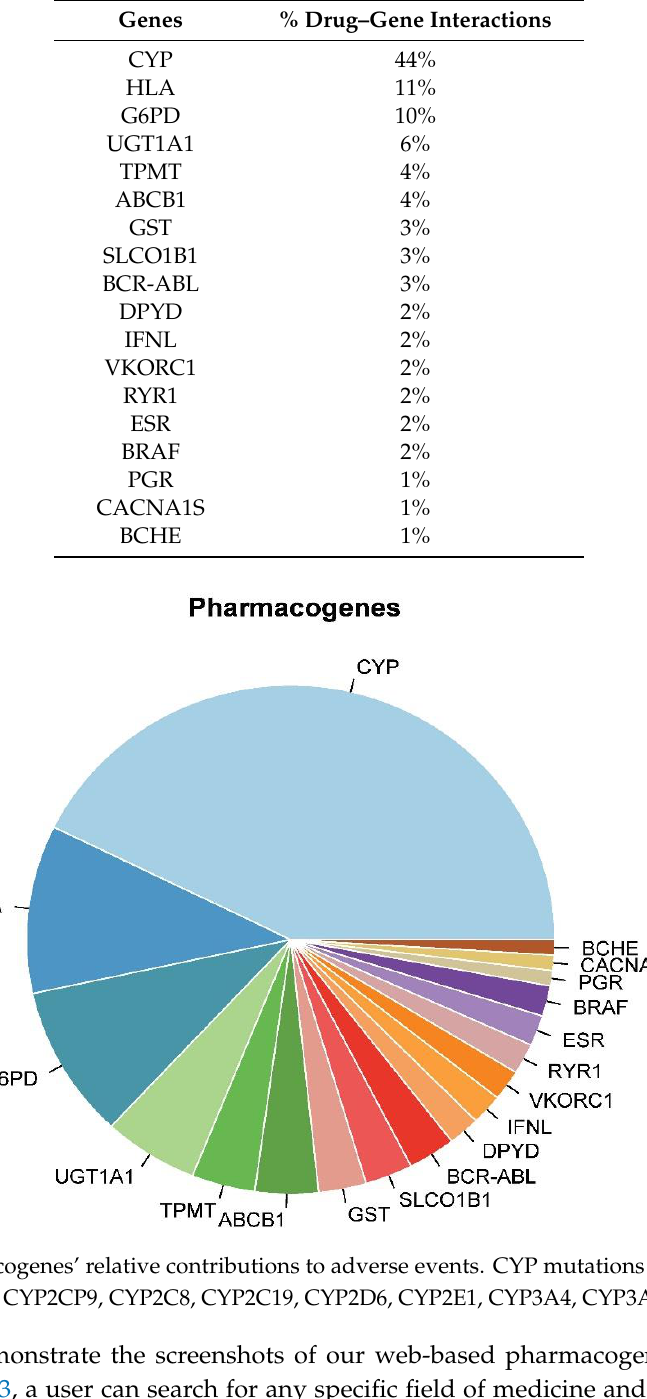
Table 3. Pharmacogenetics’ contributions for the most commonly found genes.